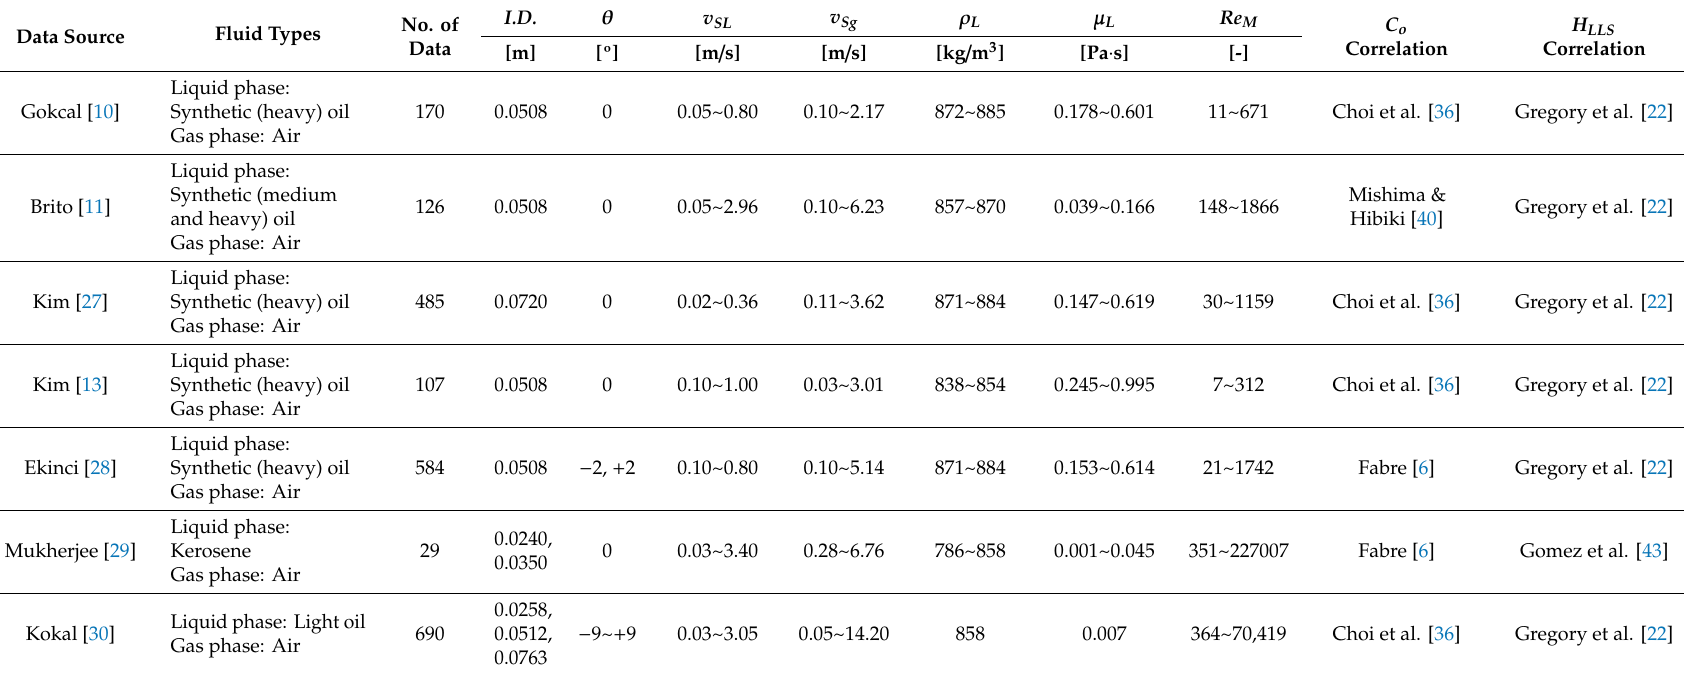
Table 7. Summary of pressure gradient, dp / dL , dataset and utilized correlations of C o and H LLS